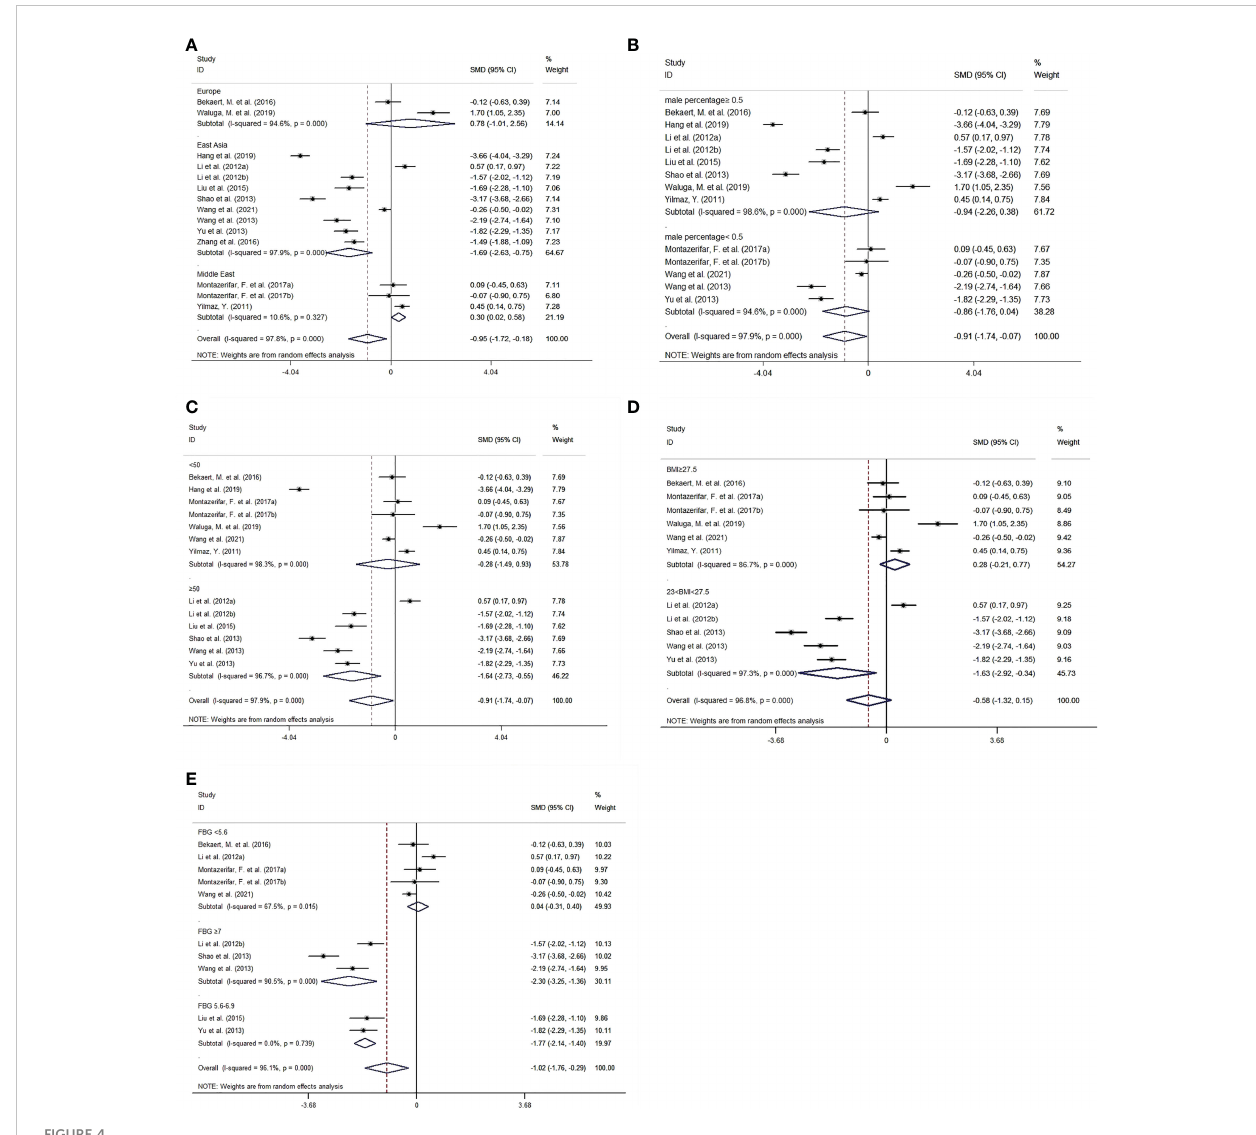
FIGURE 4 Forest plot for subgroup analysis of circulating omentin levels between MAFLD and healthy control group (Random-Effects Model, SMD ). (A) subgroup analysis by region, (B) subgroup analysis by sex, (C) subgroup analysis by age, (D) subgroup analysis by BMI, (E) subgroup analysis by